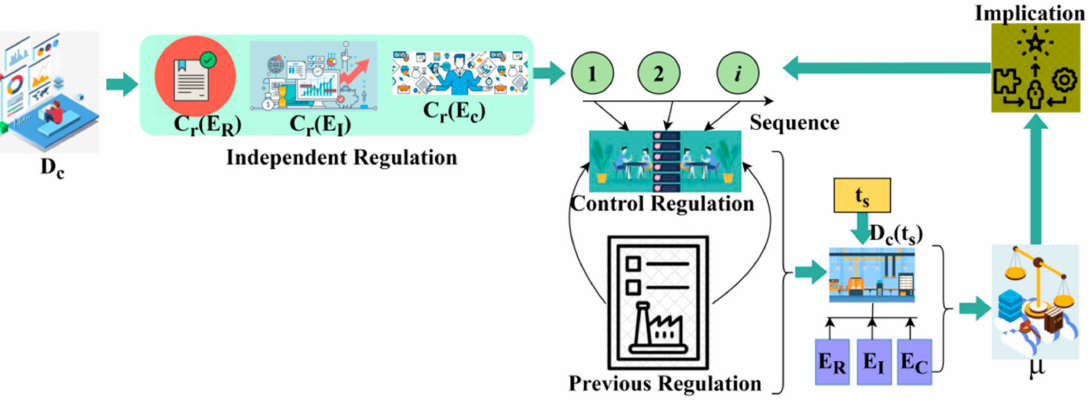
Figure 4. Emission Control Regulation